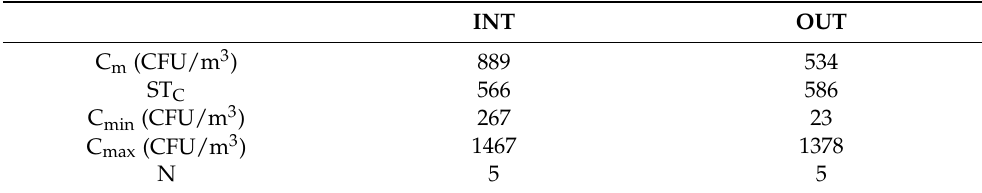
Table 6. Average concentration of total bacteria per m 3 of air (Cm, CFU/m 3 ), concentration standard deviation (ST C ), minimum concentration of total bacteria (C min , CFU/m 3 ), maximum concentration (C max , CFU/m 3 ), number of considered samples (N). Sampling date: 5 April 2022, sampling site: within the pens (INT), around the pens (OUT).